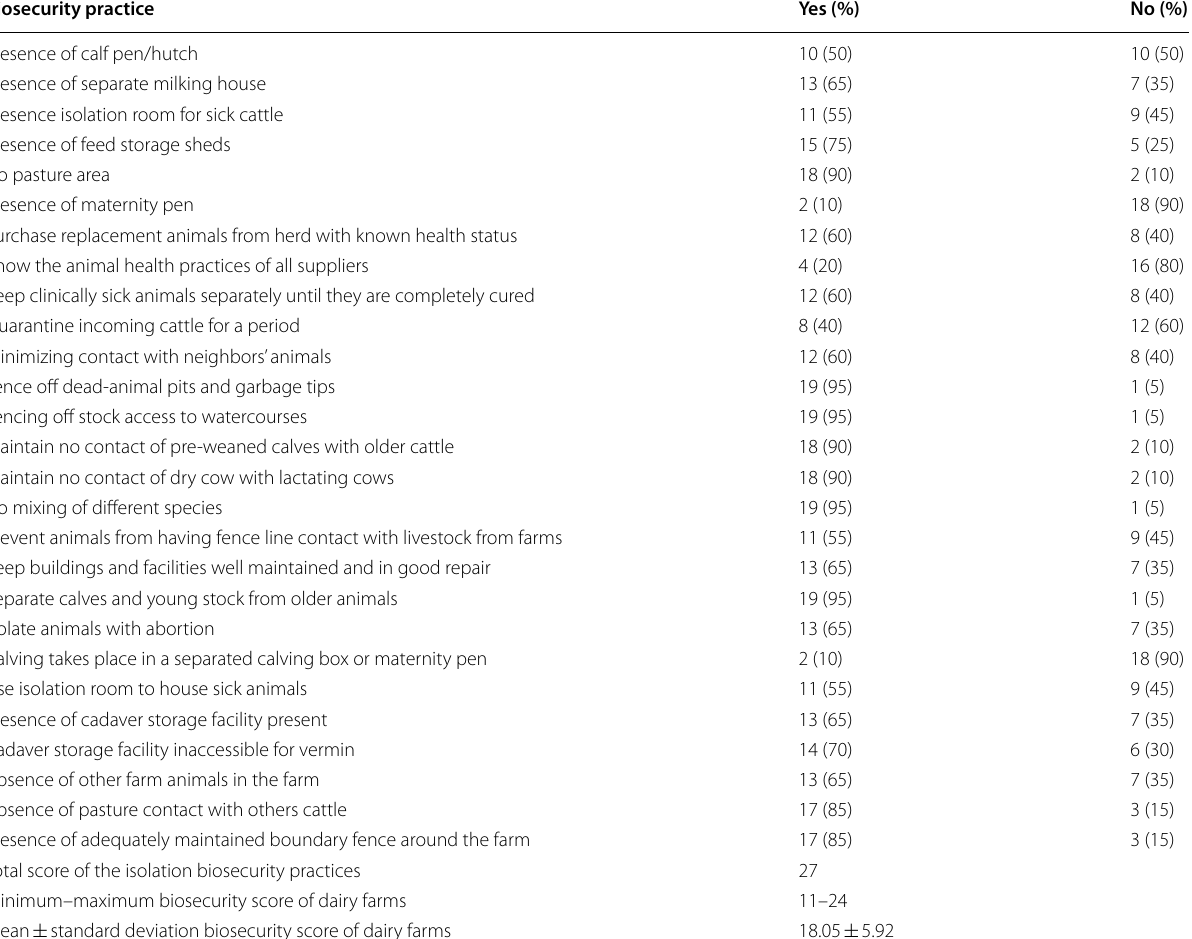
Table 5 Percentage of isolation biosecurity practices